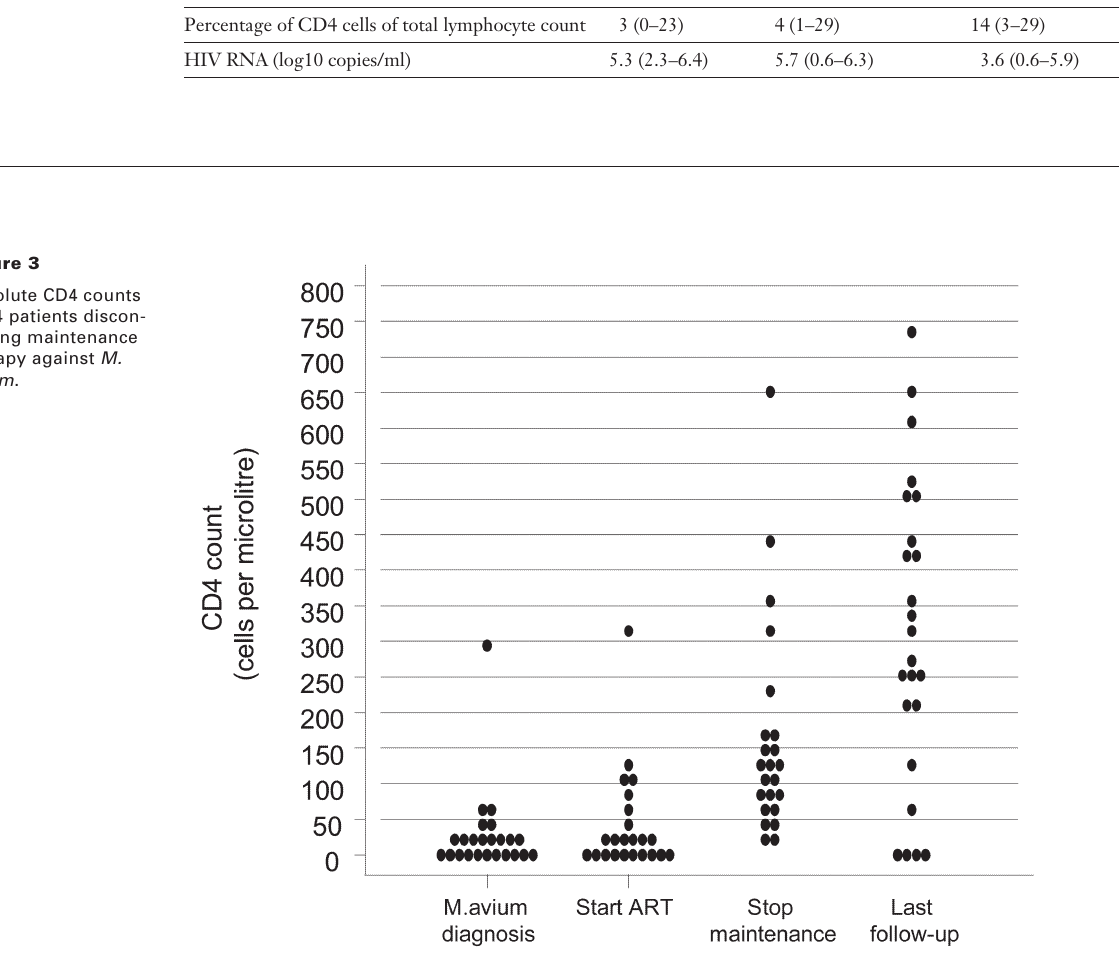
follow-up data of 24 patients who discon- tinued maintenance therapy against M. avium (median, range).